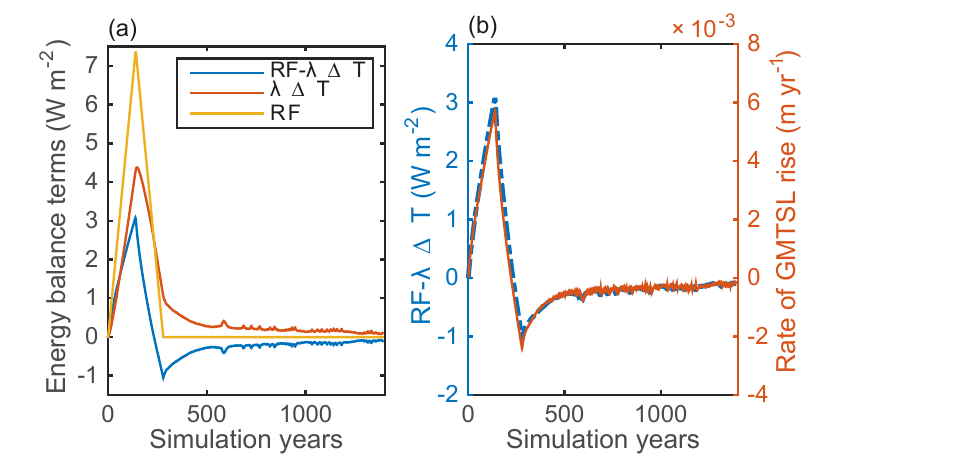
Figure 4. Energy balance terms calculated from the simulation data of the model version with default mixing setting. β/α = λ = 1Wm − 2 K − 1 is the climate feedback parameter for the default mixing setting. (cid:49)T is the change in global mean surface air temperature relative to year 0 and RF is the radiative forcing. Panel (b) compares the energy imbalance (blue y axis and curve) to the rate of global mean thermosteric sea level rise (red y axis and